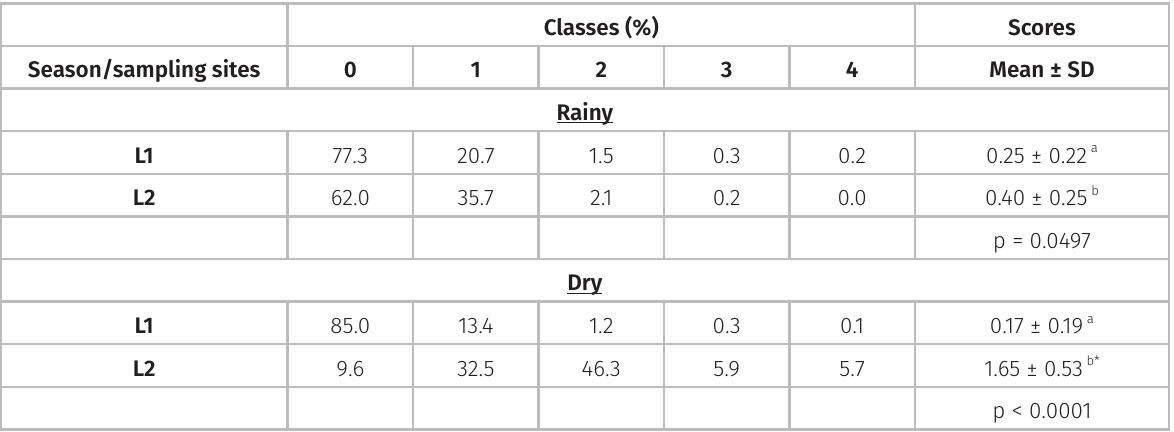
Table III. Nucleoid class frequencies and DNA damage scores (comet assay) on erythrocytes from Sciades herzbergii (Maranhão state, northeastern Brazil) at the reference site, distant from ports and urban centers/ industries, and at the vicinity of the Itaqui Port Complex (IPC) (dry and rainy seasons, 2015; n = 20 per site/season, except IPC dry season where n= 10). Different letters indicate statistically significant differences between means (rainy season: t-test, p < 0.05; dry season: Mann-Whitney-test, p <